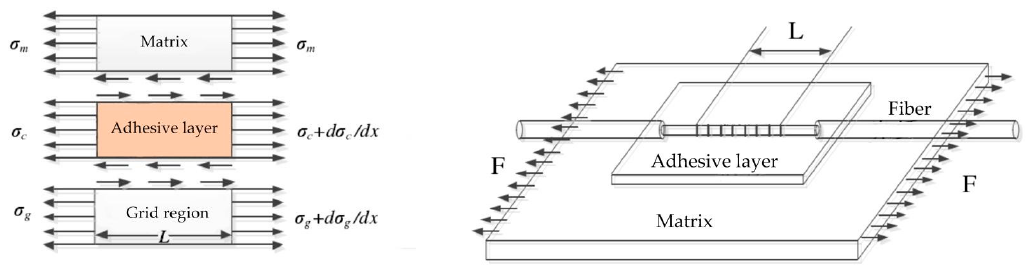
Figure 11. Mechanical transfer model of FBG sensor [38].